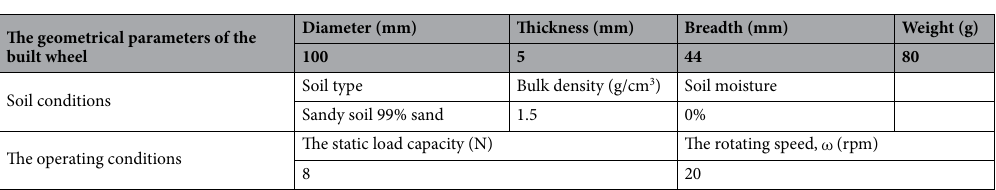
Table 1. The experimental test